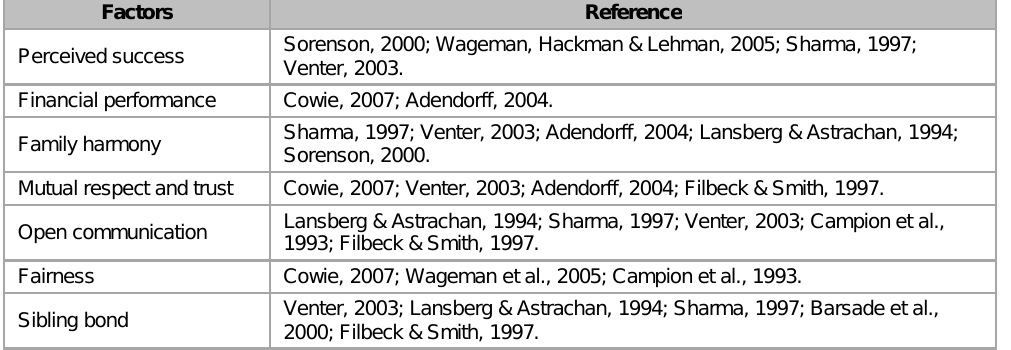
Sources of previously validated items used in the measuring